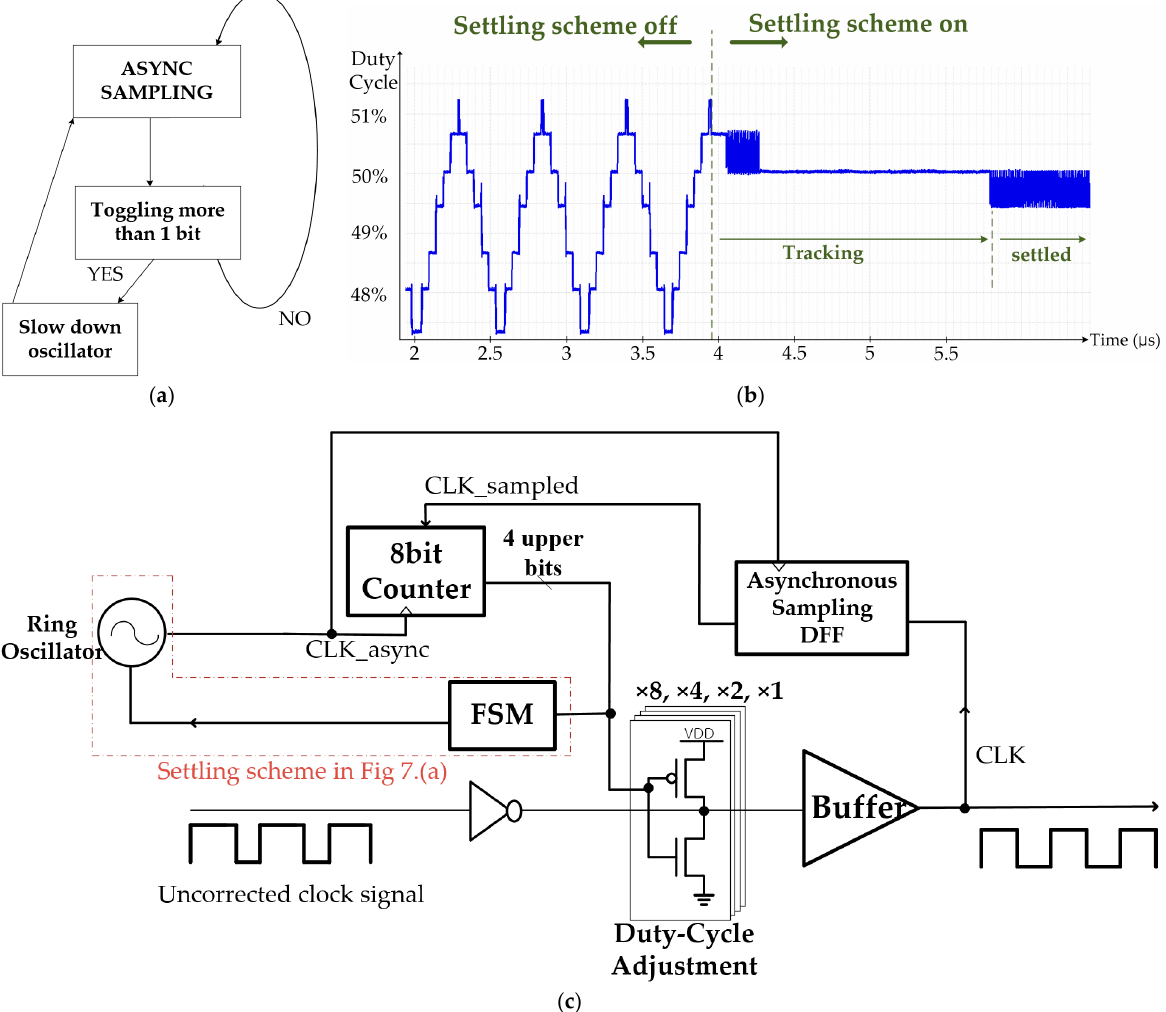
Figure 7. ( a ) Asynchronous sampling settling scheme. ( b ) The change of the duty cycle before and after the scheme turns on. ( c ) Asynchronous sampling duty cycle corrector with the settling scheme. on. ( c ) Asynchronous sampling duty cycle corrector with the settling scheme.